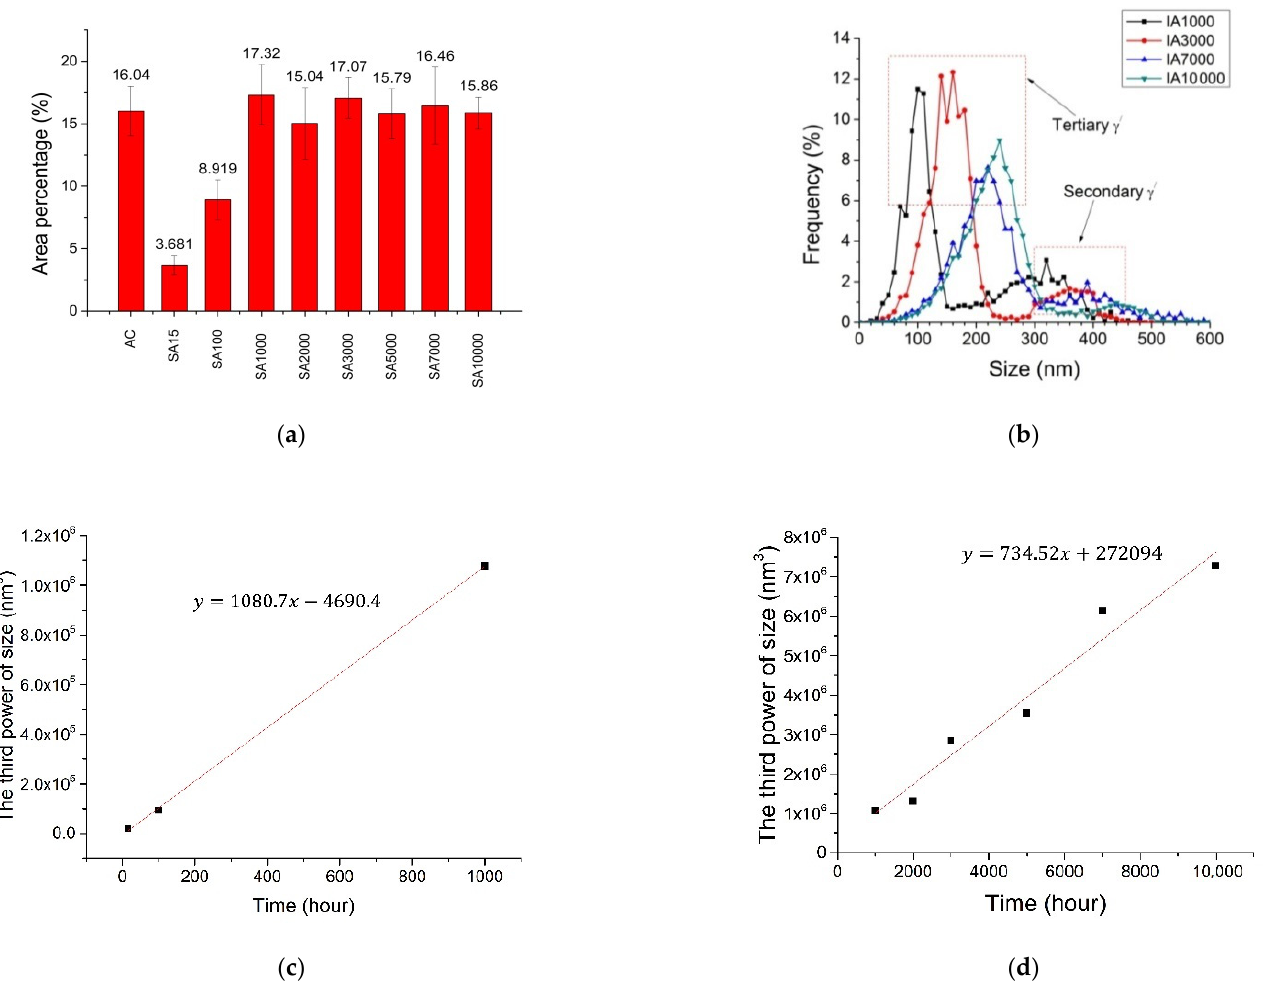
Figure 13. Bimodally distributed γ ’ particles’ diameters: ( a ) quantified area percentage of γ ’ particles; ( b ) quantified size of γ ’ particles; ( c ) a quantification plot of γ ’ size with time below 1000 h, and ( d ) a quantification plot of γ ’ with time above 1000 h.